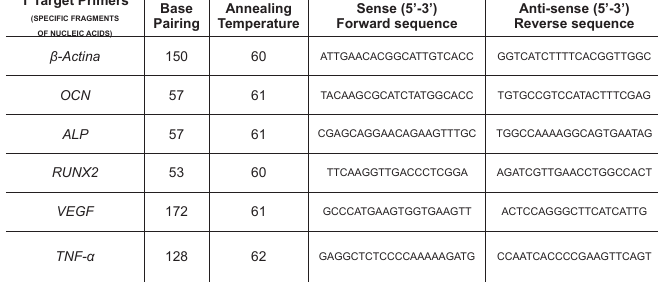
TABLE 1 – Properties of each reaction and sequences of primers for Beta-Actina, Collagen Type I/COL-I, vascular endothelial growth factor/VEGF, osteocalcin/OCN, alkaline phosphatase/ALP, runt-related transcription factor 2/RUNX2 and tumor necrosis factor alpha/TNF-α, designed by Primer Express